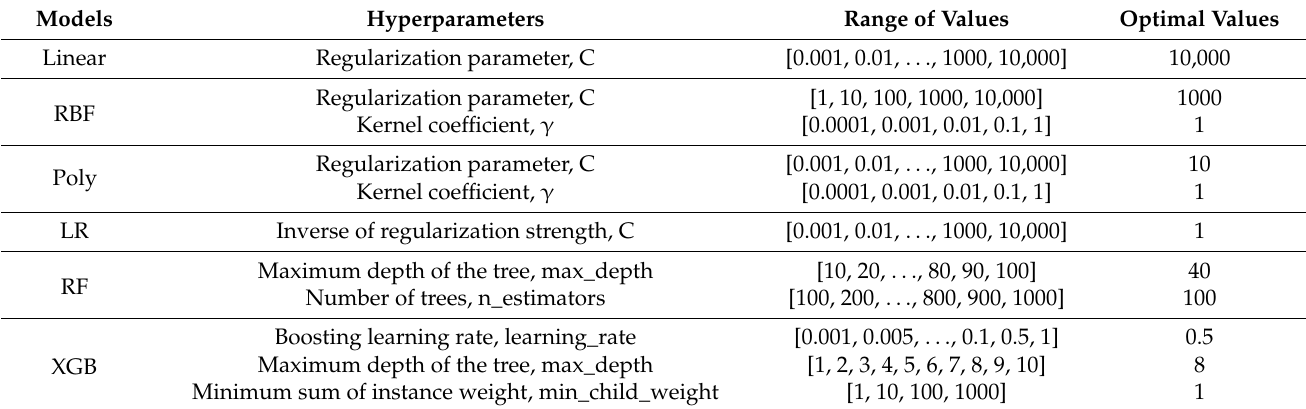
Figure 17. 10-fold CV accuracy for parameter-tuned classification methods (Case 4). Table 8. Hyperparameter tuning for each classification method (Case